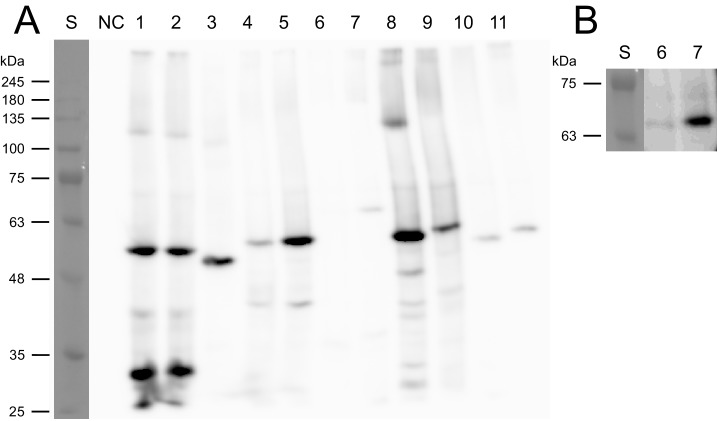
Protein expression in yeasts expressing bumble bee FARs.(A) Protein expression patterns determined in yeast cell lysates using western blot followed by detection with anti-6 ×His tag antibody. (B) Detail of the FAR-J full-length protein region with increased photograph contrast. Lanes: S, protein standard (VI, AppliChem); NC, negative control (yeast carrying empty vector); 1–11, yeast strains carrying plasmids with BlucFAR-A1 (1), BterFAR-A1 (2), BlapFAR-A1 (3), BlucFAR-A2 (4), BterFAR-A2 (5), BterFAR-J (6), BlapFAR-J (7), BlapFAR-A4 (8), BlapFAR-A5 (9), BlucFAR-A1-opt (10) and BlucFAR-A2-opt (11).